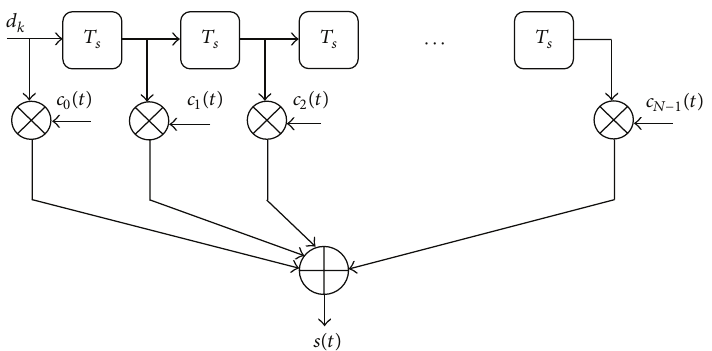
Figure 2: The code-time diversity DSSS